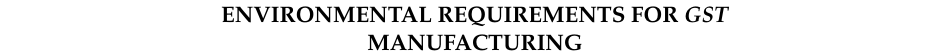
Table 6. Main environmental requirements for GST